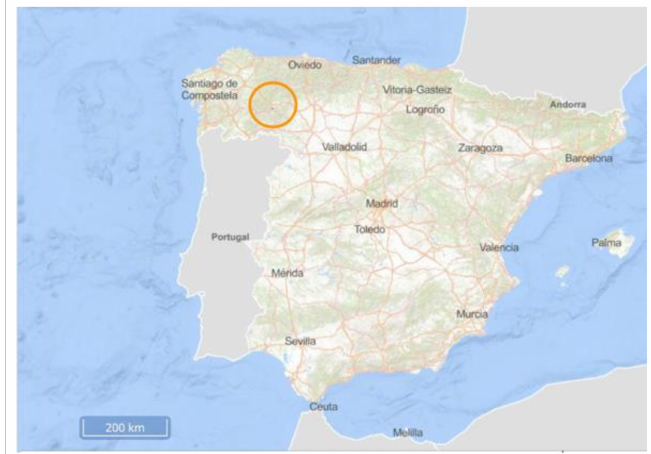
Figure 1. Situation of Las M é dulas. Source: National center for geographical information